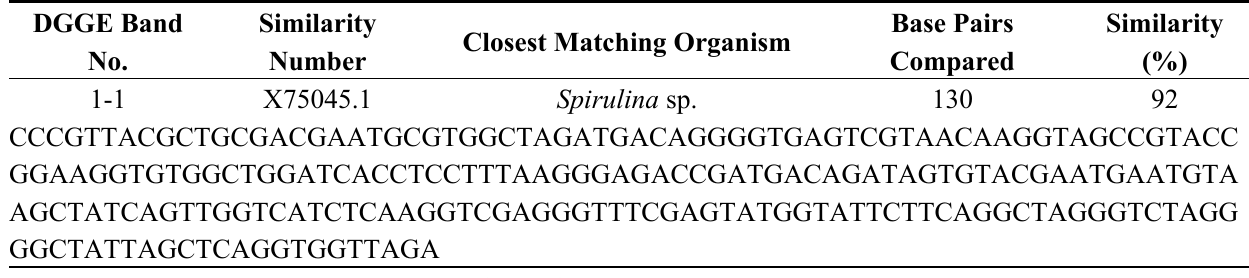
Table A2. List of DNA sequences of bands in Table